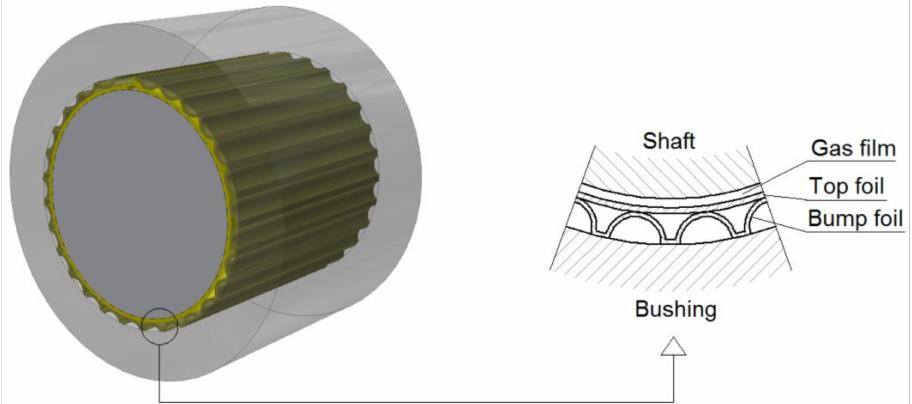
Figure 1. Typical geometry of a bump-type radial GFB. The top and bump foils compose a structural part of the bearing’s supporting layer, whereas the gas film creates a fluidic layer in addition. Both layers ensure the required suspension and elevation capability for the rotating shaft’s journal in a GFB while its operation.